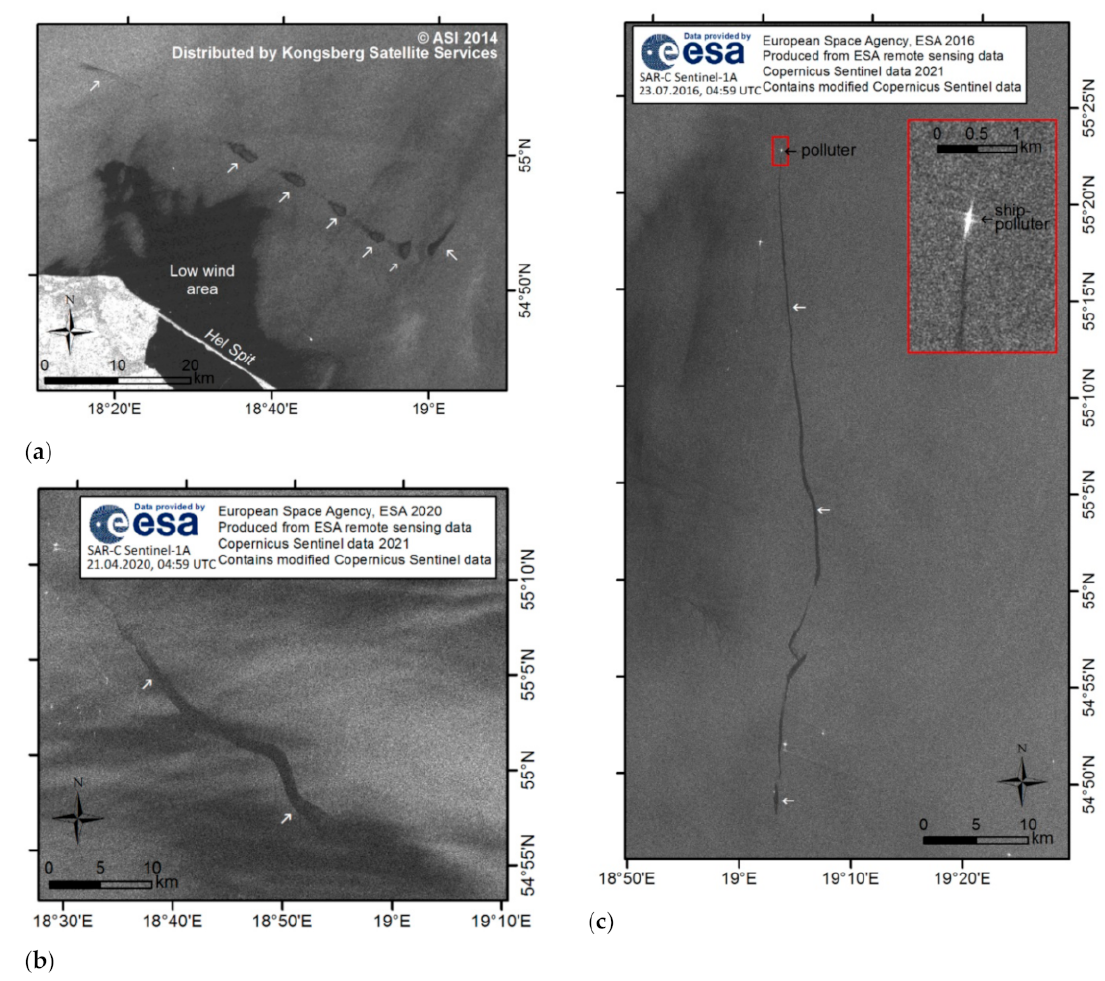
Figure 3. Examples of tail-shaped oil spills. Oil spills are shown with white arrows. A black arrow points to the polluter. ( a ) COSMO-SkyMed-4 11.11.2014 (04:09 UTC); ( b ) Sentinel-1A 21.04.2020 (04:59 UTC); and ( c ) Sentinel-1A 23.07.2016 (04:59 UTC).